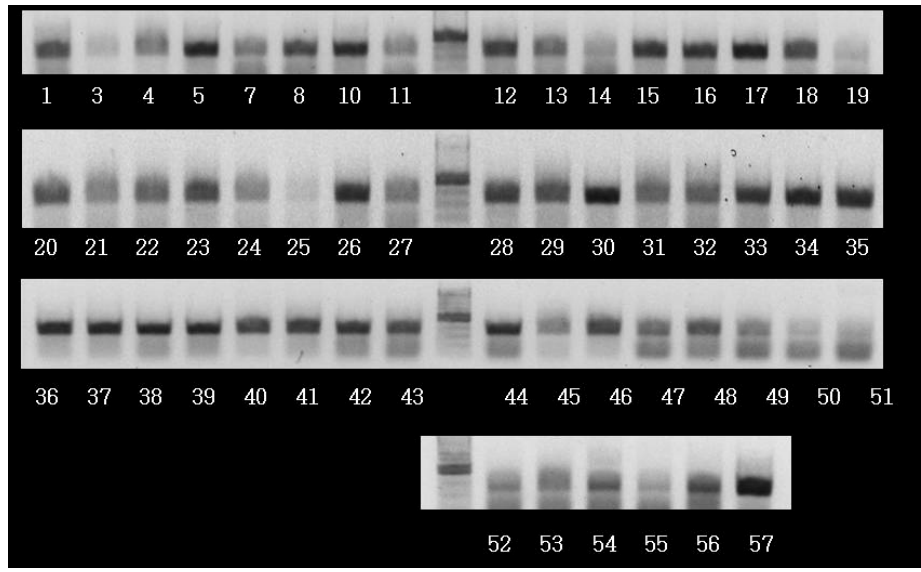
Figure 3. Result of electrophoresis of ALCAM transcripts after reverse transcriptase polymerase chain reaction ( RT-PCR).